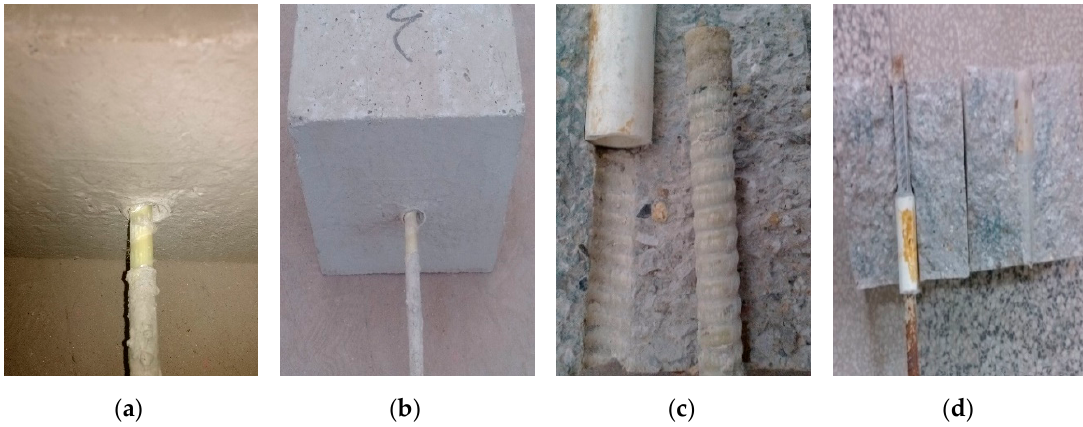
Figure 10. Typical failure modes of glass fibre-reinforced polymer (GFRP) bars exhibited by specimens with pullout failure: ( a ) R1, ( b ) R2, ( c ) R3, and ( d ) R4.